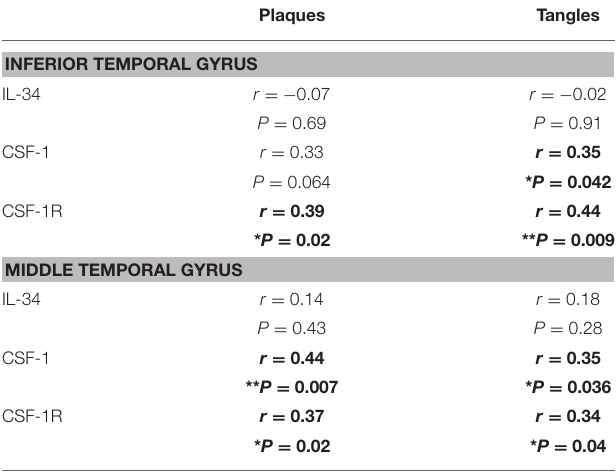
TABLE 3 | Correlations of IL-34, CSF-1, and CSF-1R mRNA expression with plaque and tangle pathology. Plaques Tangles